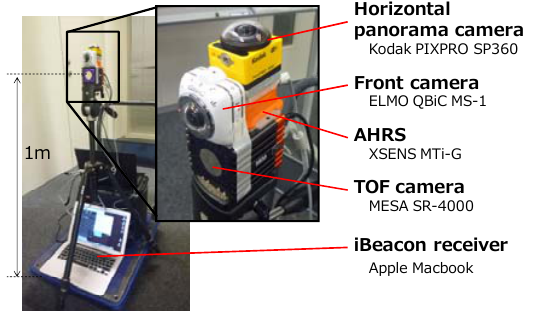
Figure 6. Indoor 3D data acquisition system